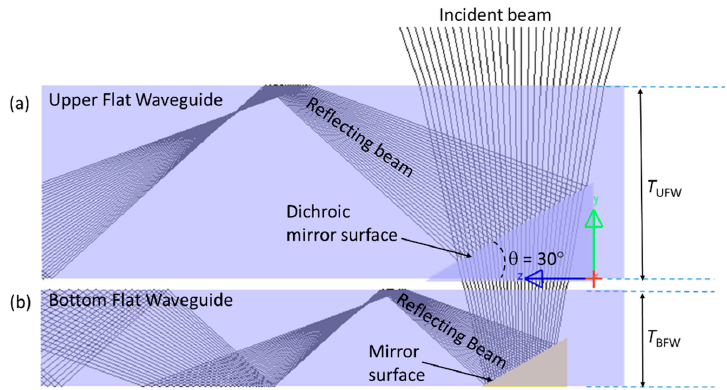
Figure 5. The design of redirecting mirrors in the: ( a ) upper flat waveguide (UFW) and ( b ) bottom flat waveguide (BFW).